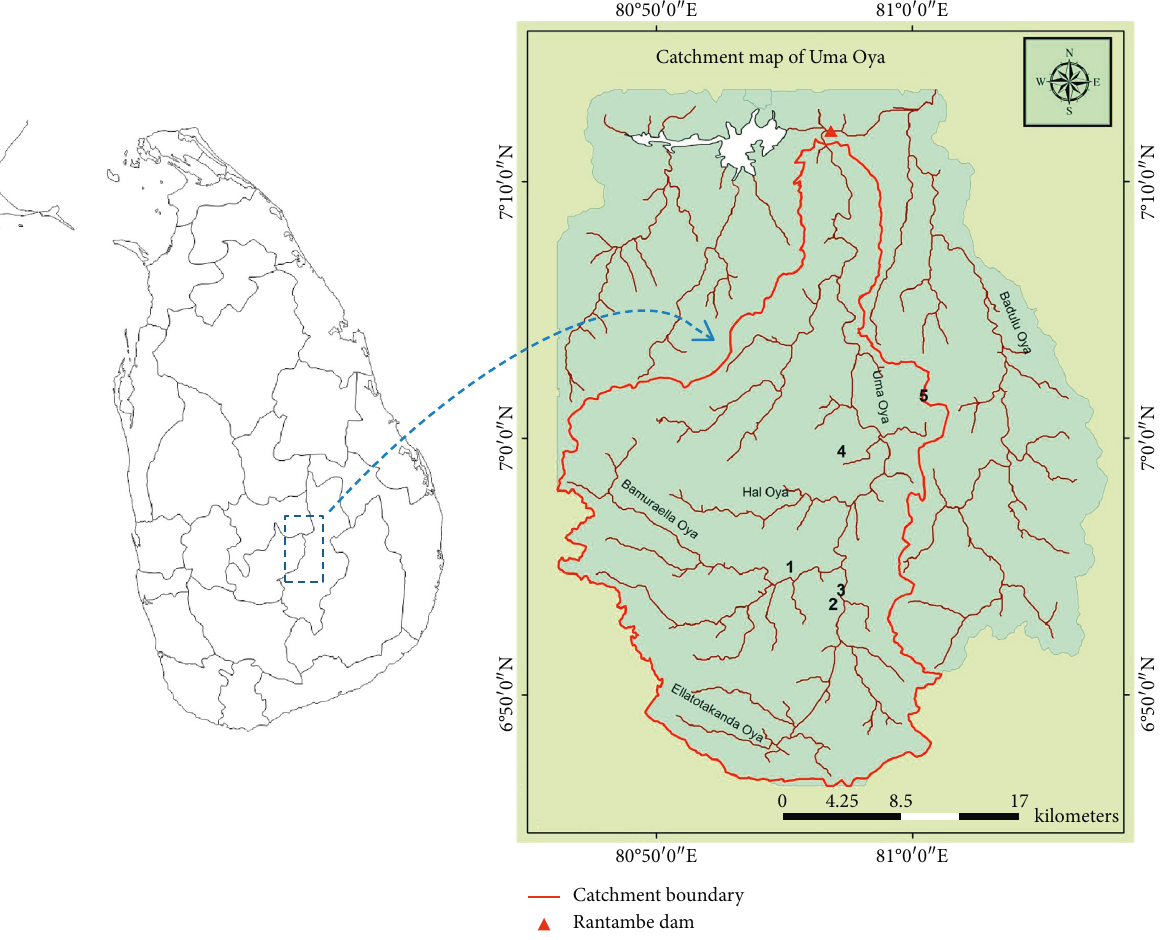
Figure 1: Uma Oya catchment and selected rain gauges.